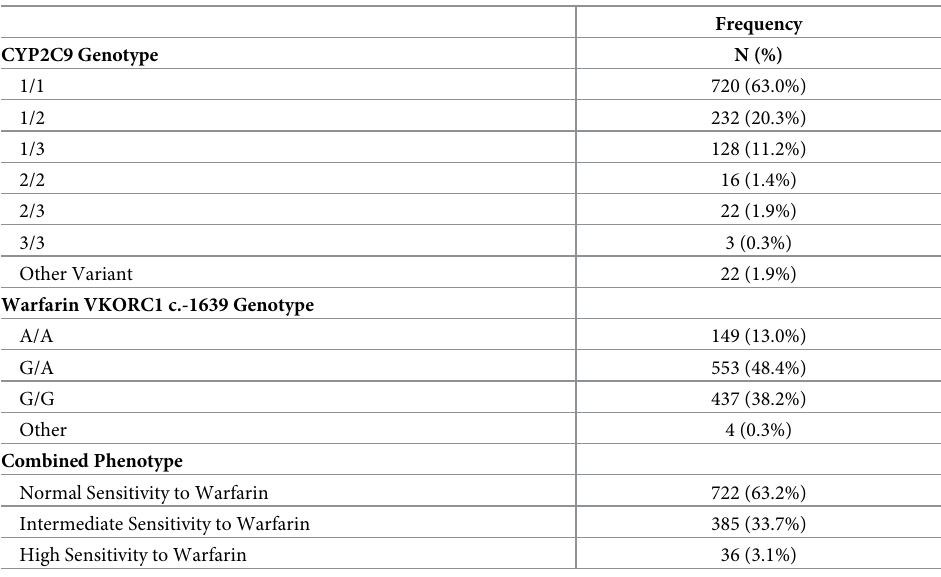
Table 1. Distribution of warfarin related genetic